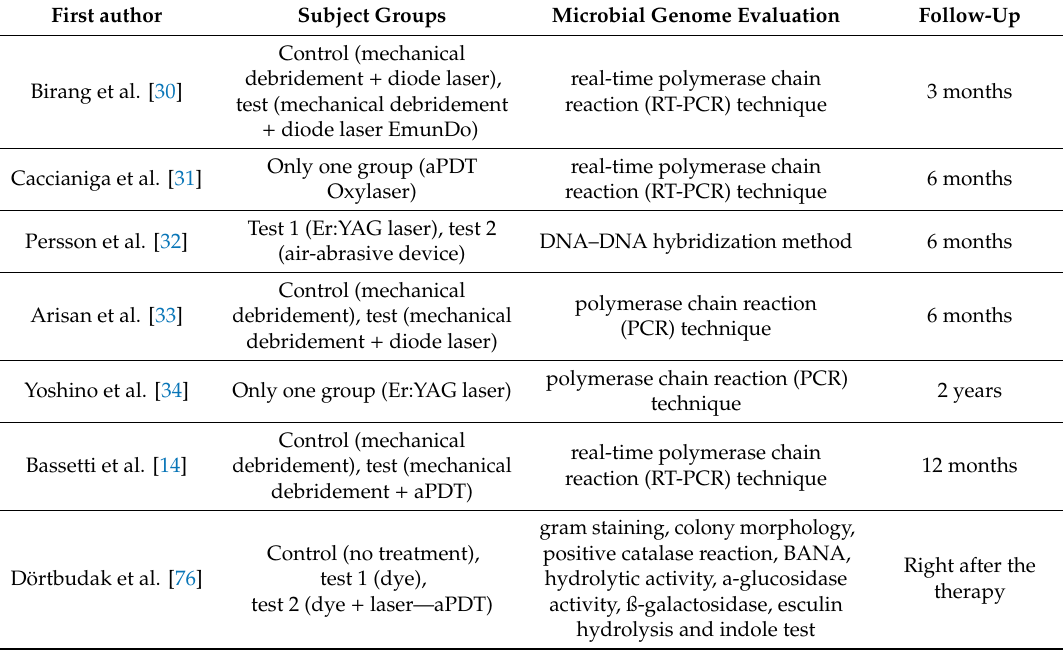
Table 5. Follow-up and microbial test assessment of the included studies.